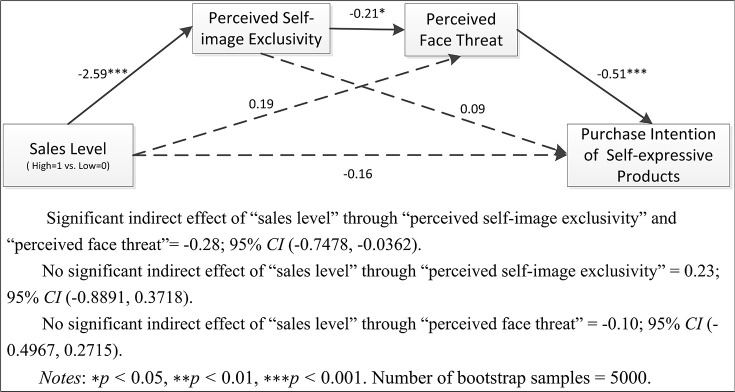
Indirect effect of sales level on purchase intention of self-expressive products.